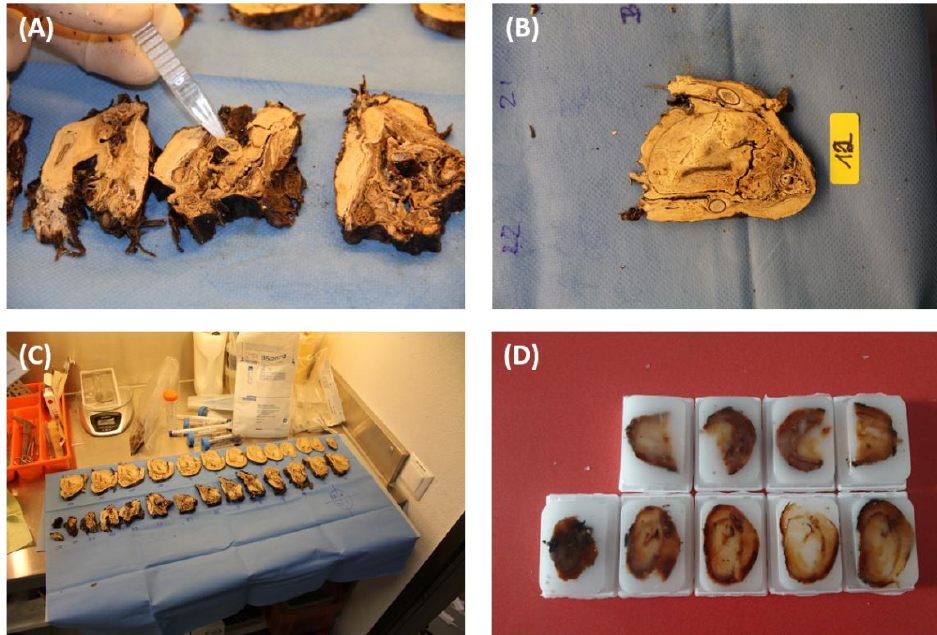
Figure 2. Sample collection. ( A ) Sample for DNA sequencing; ( B ) 3 – 5 mm slice of the mummy; ( C ) overview of the sequentially sliced mummy from caudal to cranial at 3 – 5 mm intervals; ( D ) paraffin- embedded tissue blocks.